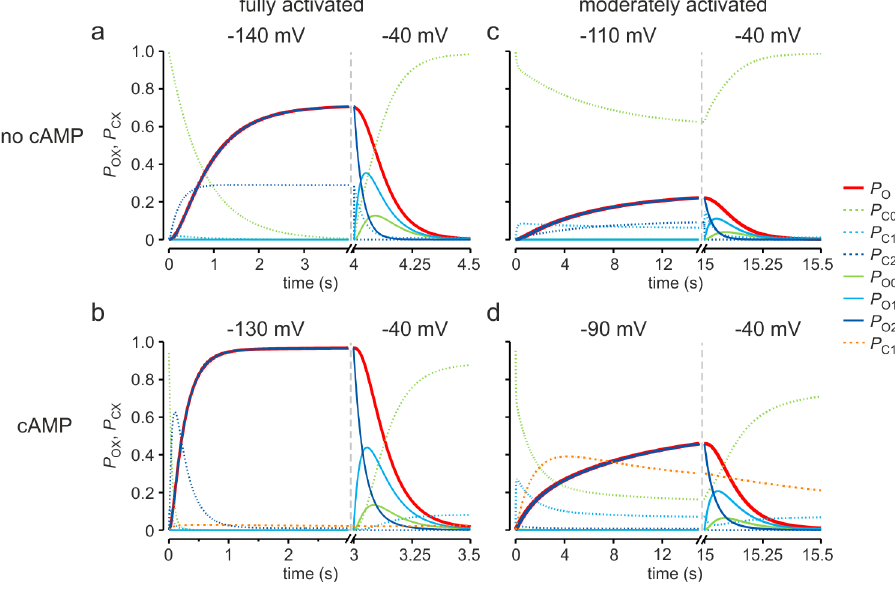
Fig 3. Effect of cAMP on the time-dependent population of states. The time courses were computed with model 1 n (no cAMP) or 1 a (10 μM cAMP). ( a , b ) Full activation and deactivation without and with cAMP. ( c , d ) Moderate voltage-dependent activation and deactivation without and with